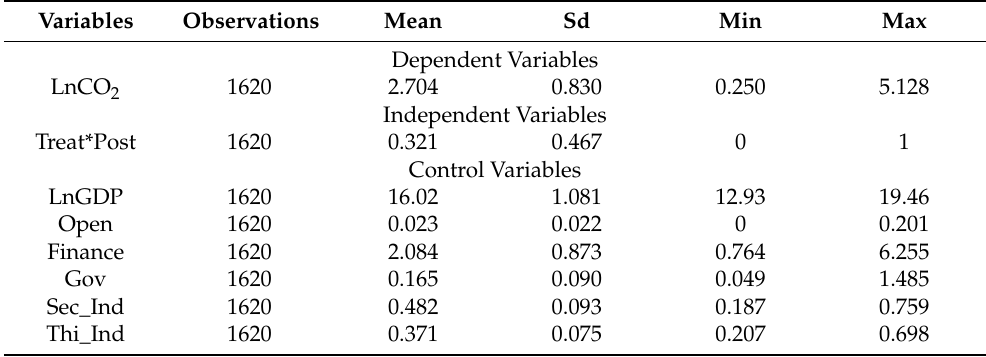
Table 2. Descriptive statistics of the